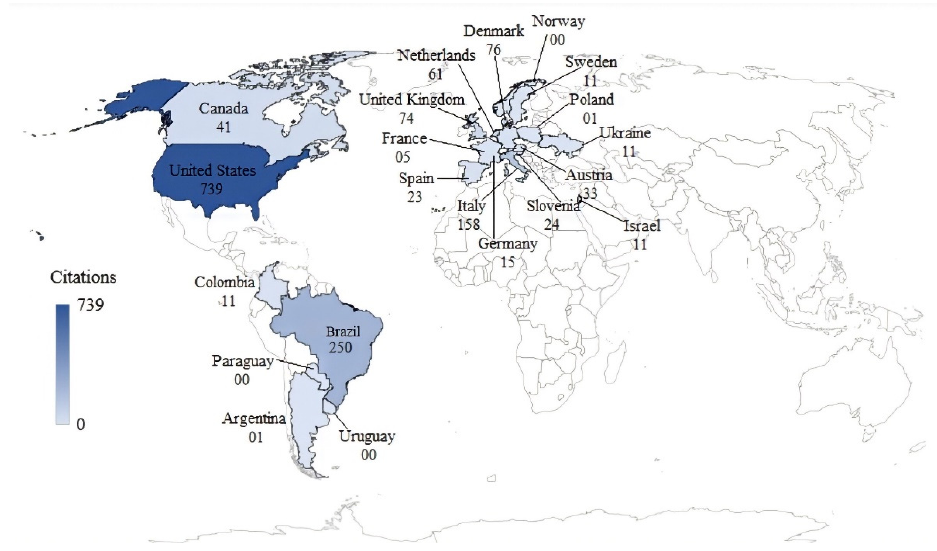
Figure 5. Number of citations by country.